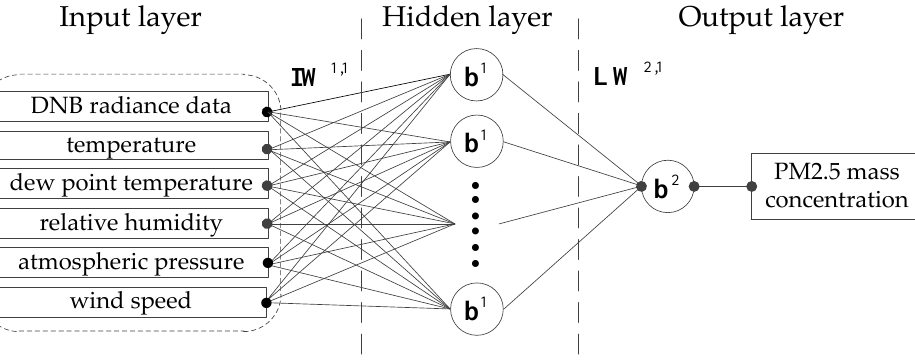
Figure 2. The 6-13-1 topological structure of the BP neuron network model.